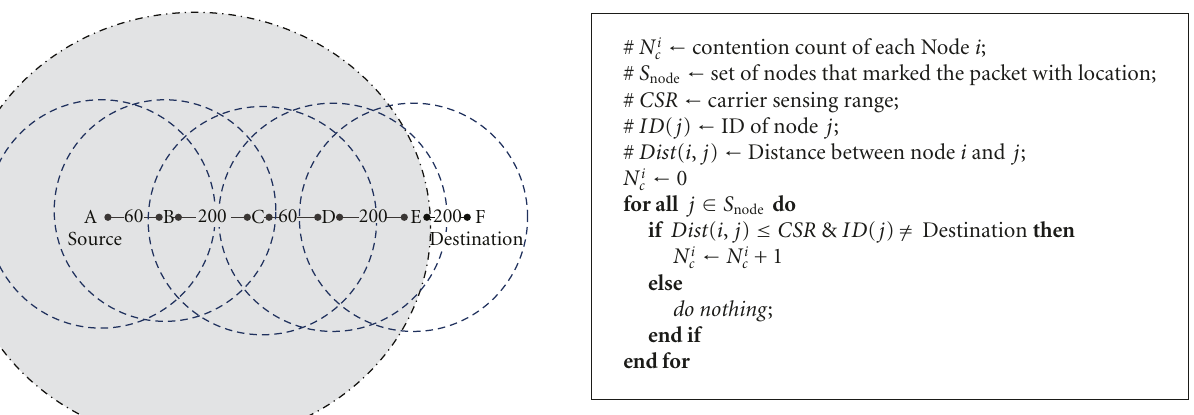
Algorithm 2: IAC/O: Estimation of N c of each